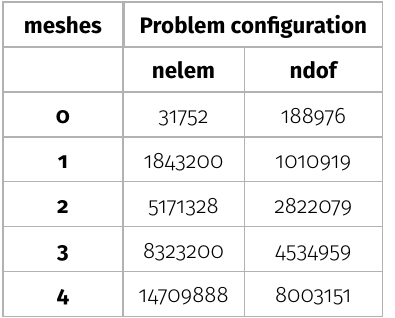
Table II. Different meshes analyzed.